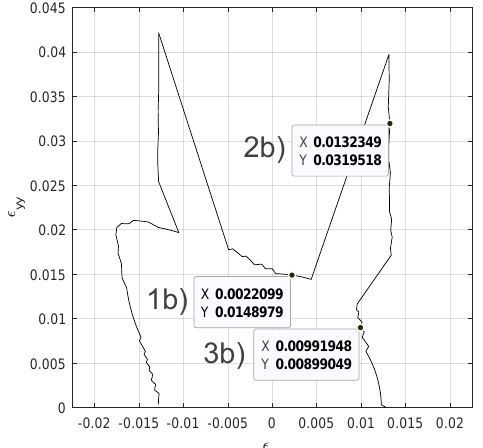
Figure 10. Failure envelope with crack stiffness G = 2.00 × 10 13 Pa. Stress ratio to peak failure criterion. Coordinates to extract configurations of failure regions 1 b –2 b –3 b